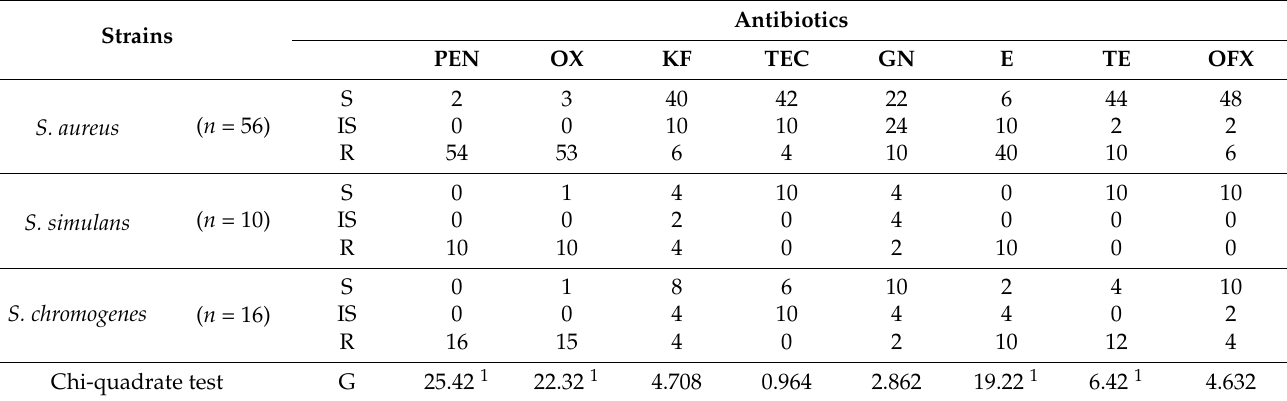
Table 3. Number of susceptible (S), intermediately susceptible (IS) and resistant (R) species of Staphylococcus